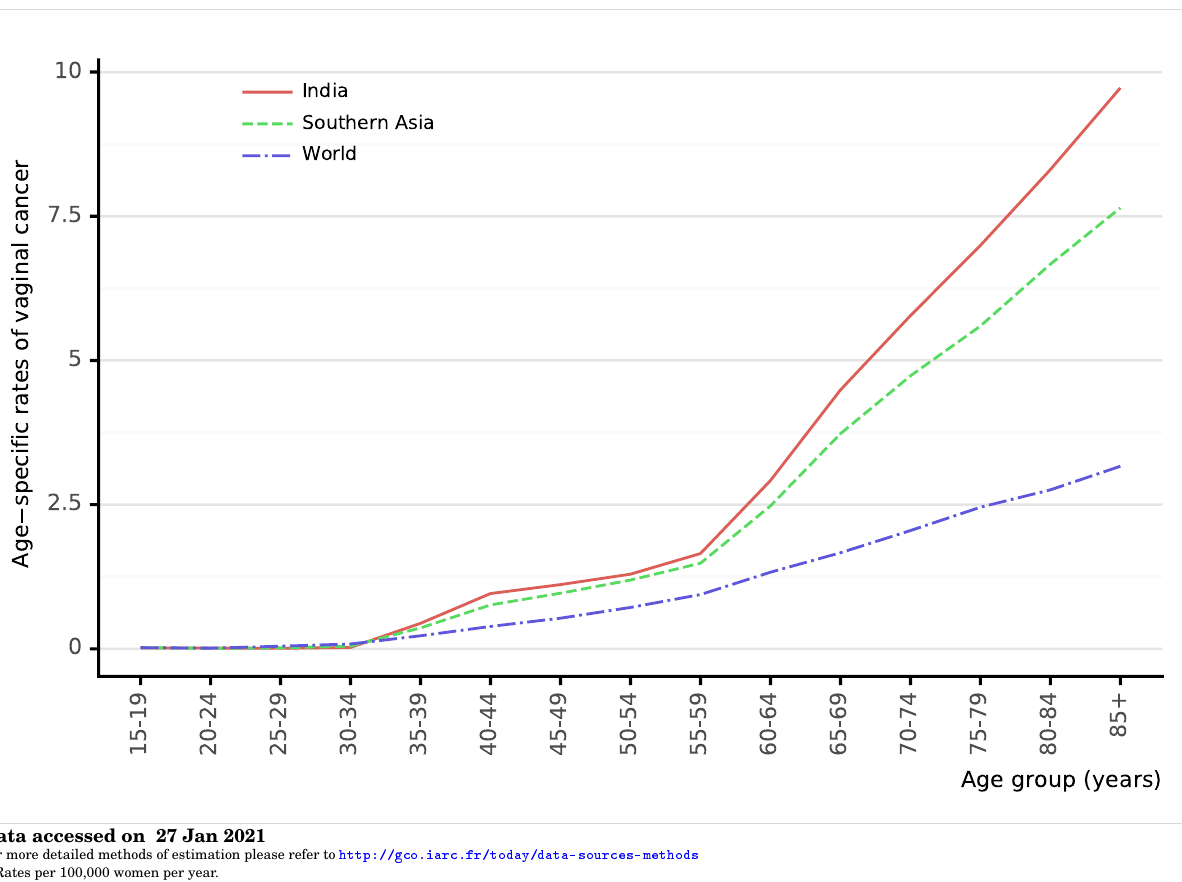
Figure 86: Comparison of age-specific vaginal cancer incidence rates in India, within the region, and the rest of